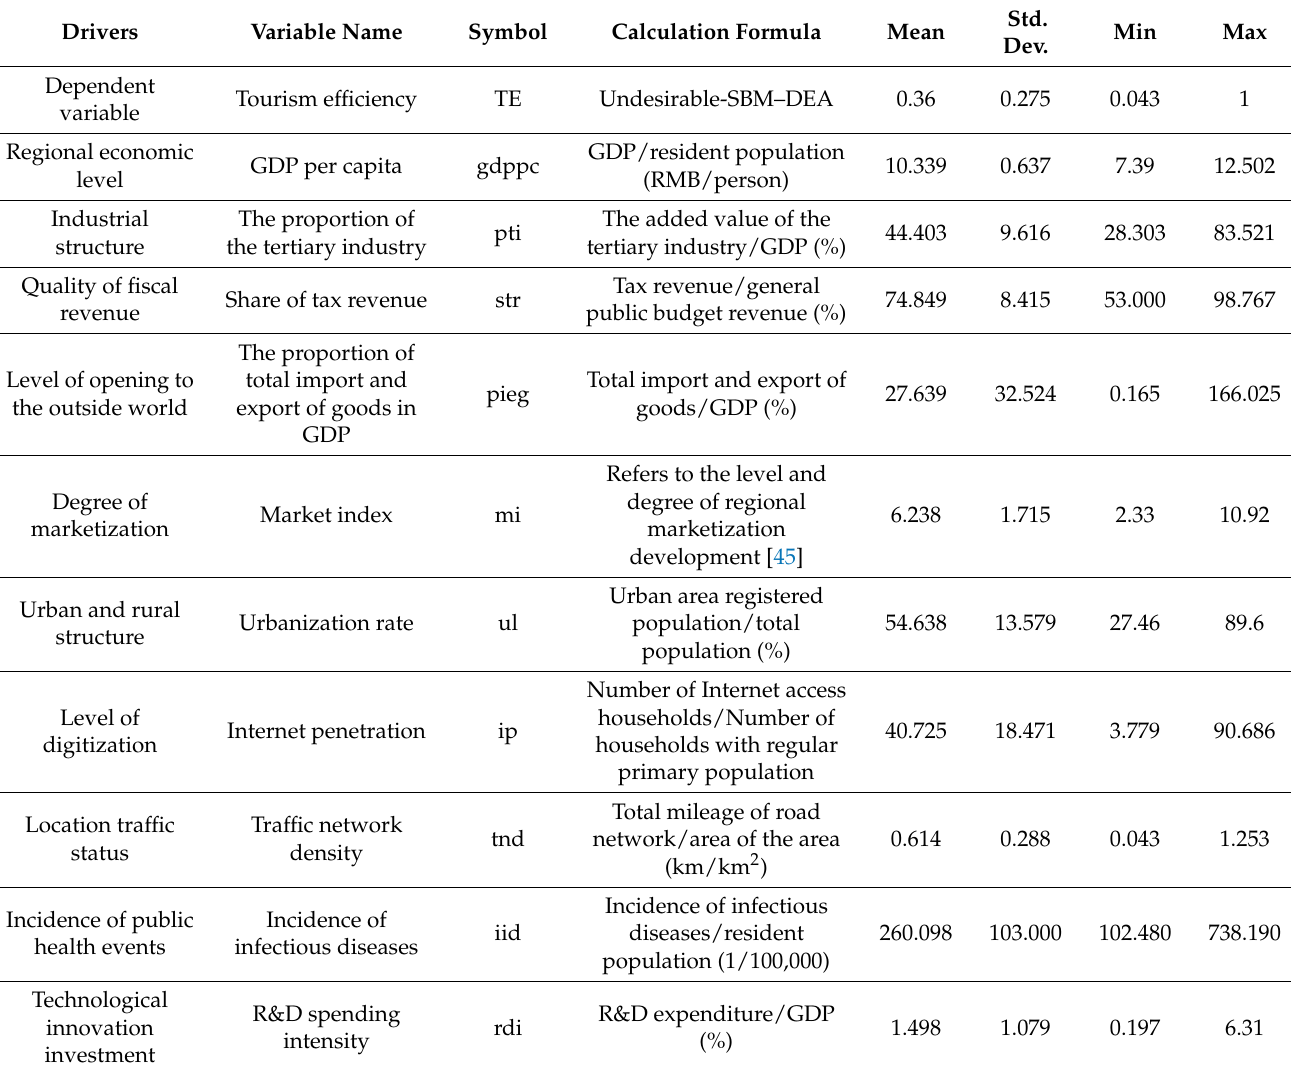
Table 3. Descriptive statistics of variables related to tourism efficiency